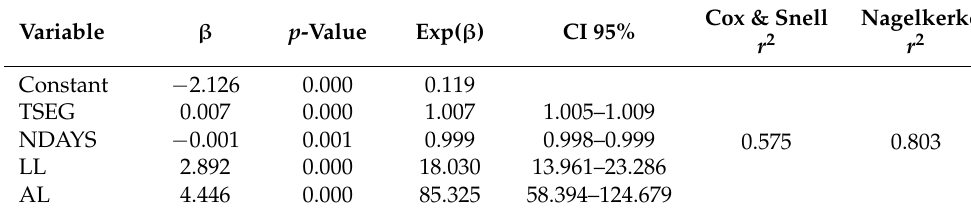
Table 6. Results of the logistic regression